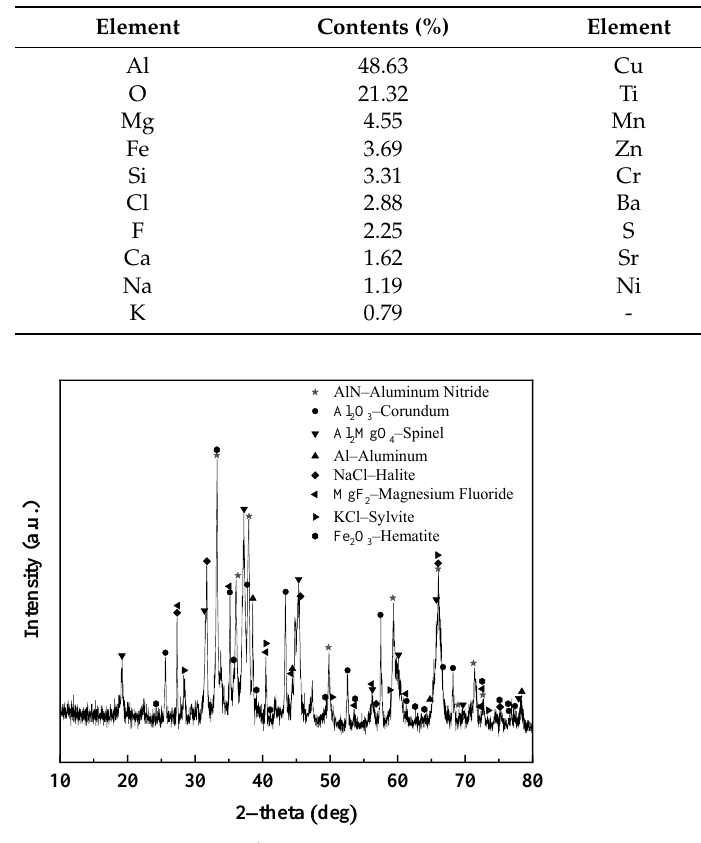
Figure 2. XRD spectra of raw SAD.